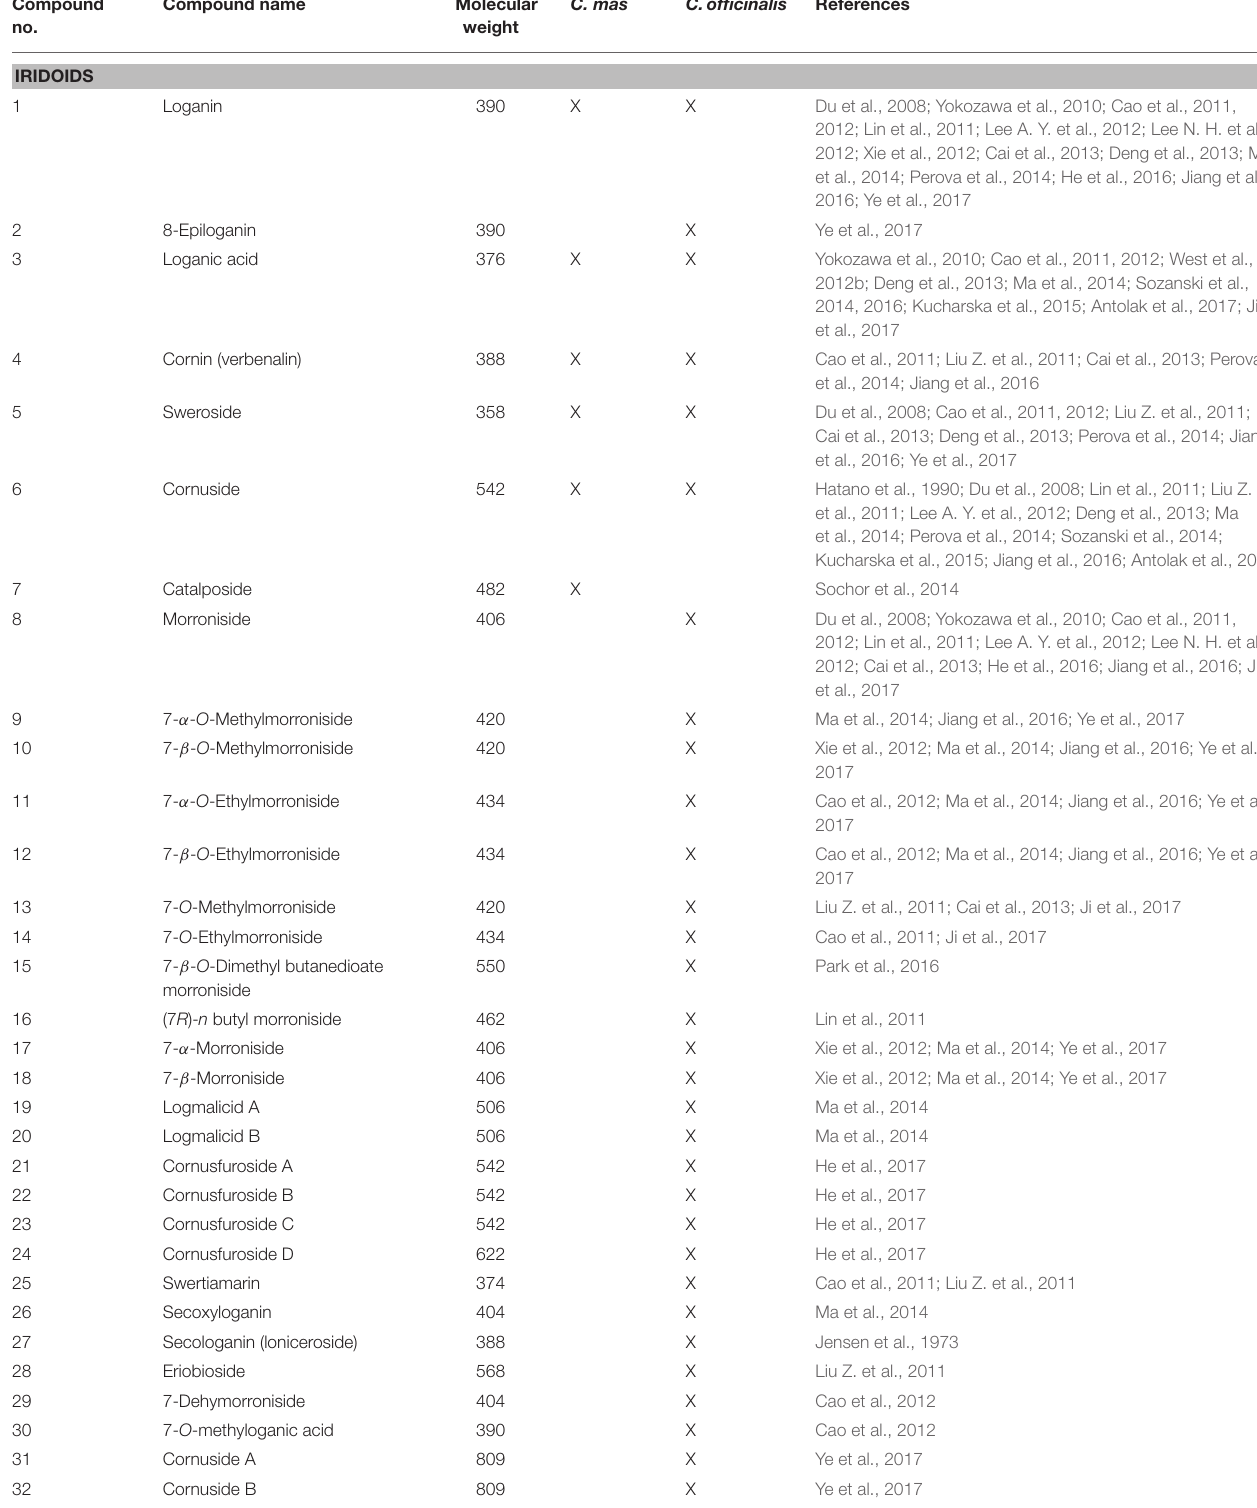
TABLE 1 | The comparison of phytochemical constituents from fruits of C. mas and C. officinalis . Compound